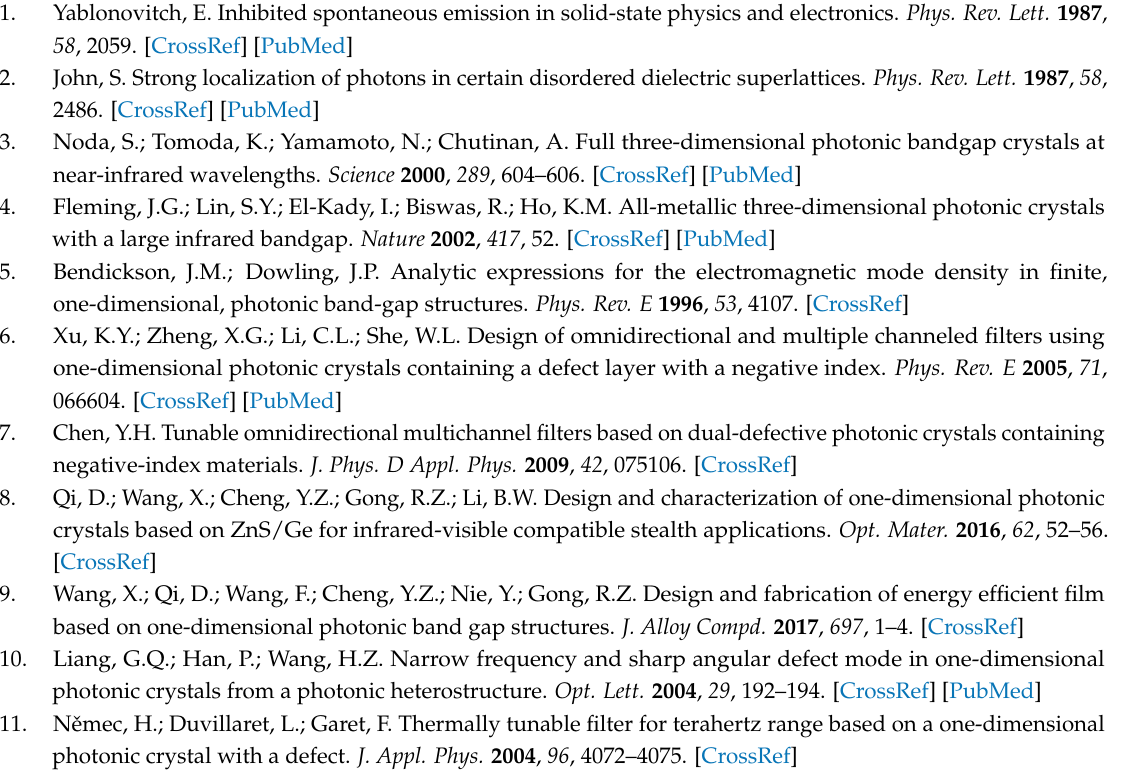
Table S1: Common use materials and evaporation technical data, Table S2: The influence of different incident angles to the properties of